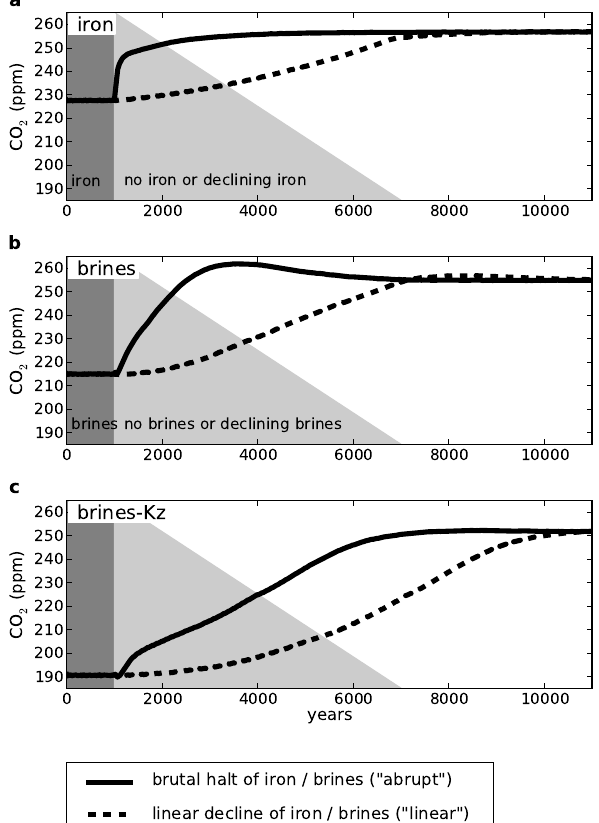
Fig. 2. Evolution of atmospheric CO 2 with a constant climate for three mechanisms: (a) iron fertilization, (b) sinking of brines and (c) sinking of brines and interactive vertical